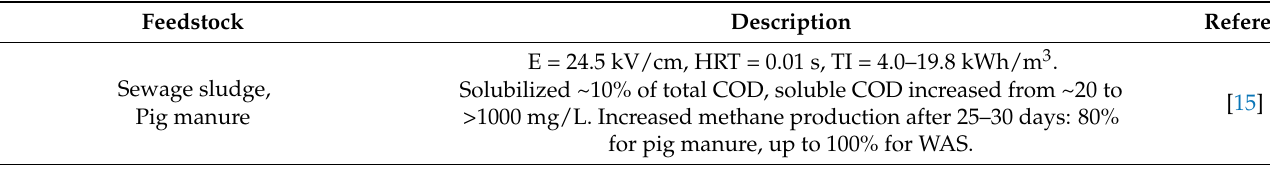
Table 1. Reported PEF application in biogas augmentation from various